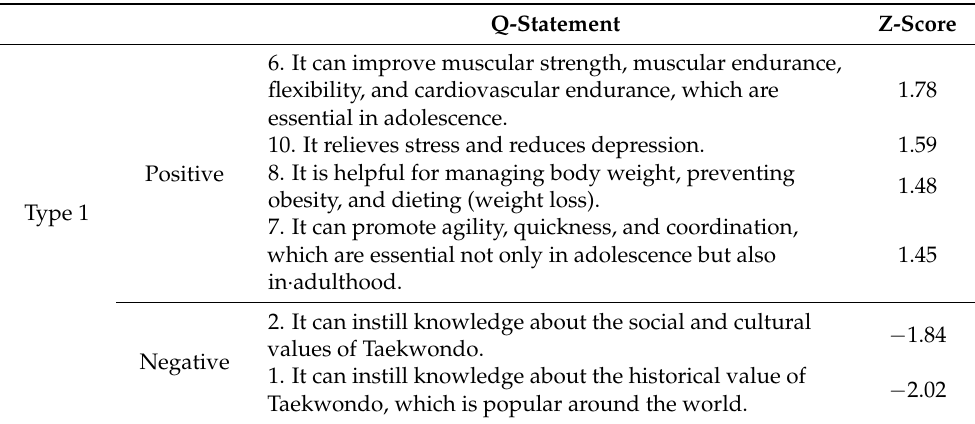
Table 5. Statements with Z-scores of ± 1.00 (or higher) type 1 to type